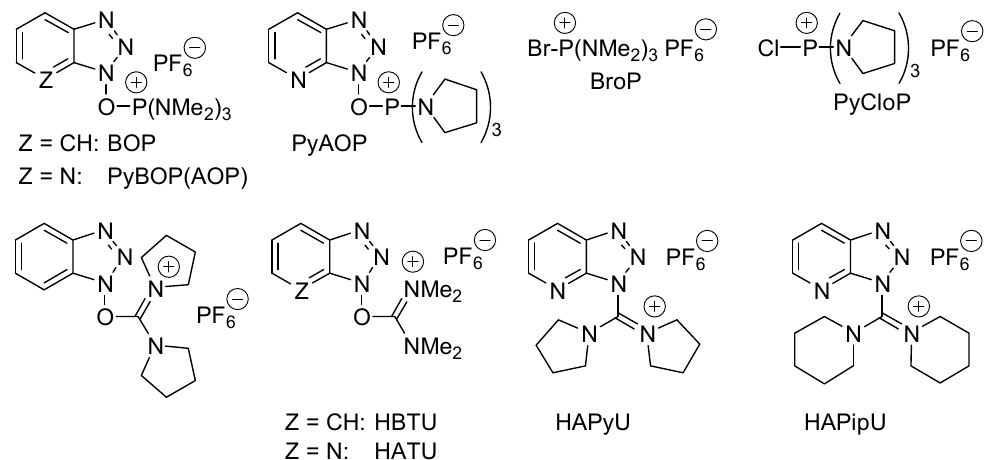
Figure 9. Examples of coupling-reagents for the one-pot amide (peptide) bond formation from Figure 9. Examples of coupling ‐ reagents for the one ‐ pot amide (peptide) bond formation from carboxylic acids and amines. Figure 9. Examples of coupling ‐ reagents for the one ‐ pot amide (peptide) bond formation from carboxylic acids and amines. carboxylic acids and amines. Figure 9. Examples of coupling ‐ reagents for the one ‐ pot amide (peptide) bond formation from carboxylic acids and